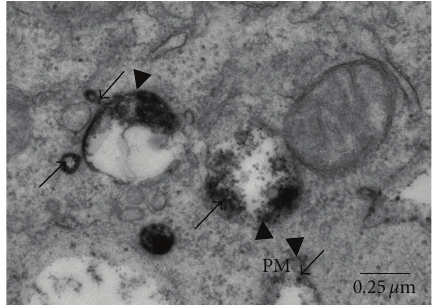
Figure 5: The gangliosides follow the same endocytic pathway as Fc ε RI. At 15 minutes of incubation with both mAb BC4- gold (which recognizes the α subunit of Fc ε RI) and mAb AA4- HRP (which recognizes gangliosides derived from GD 1b ), the BC4- gold (arrows) and AA4-HRP (arrowheads) are colocalized in early endosomes adjacent to the plasma membrane